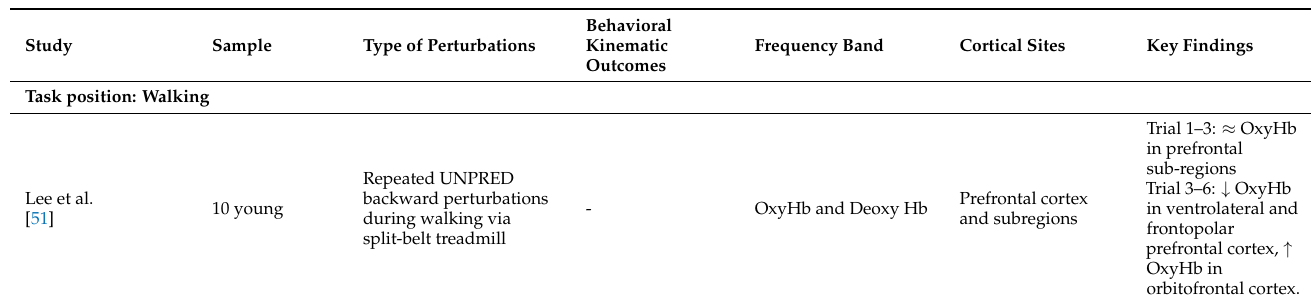
Table 7. Changes in oxygenated and deoxygenated hemoglobin (Hb) levels recorded via functional near-infrared spectroscopy (fNIRS) in response to repeat-ed unpredictable (UNPRED) mechanical perturbations